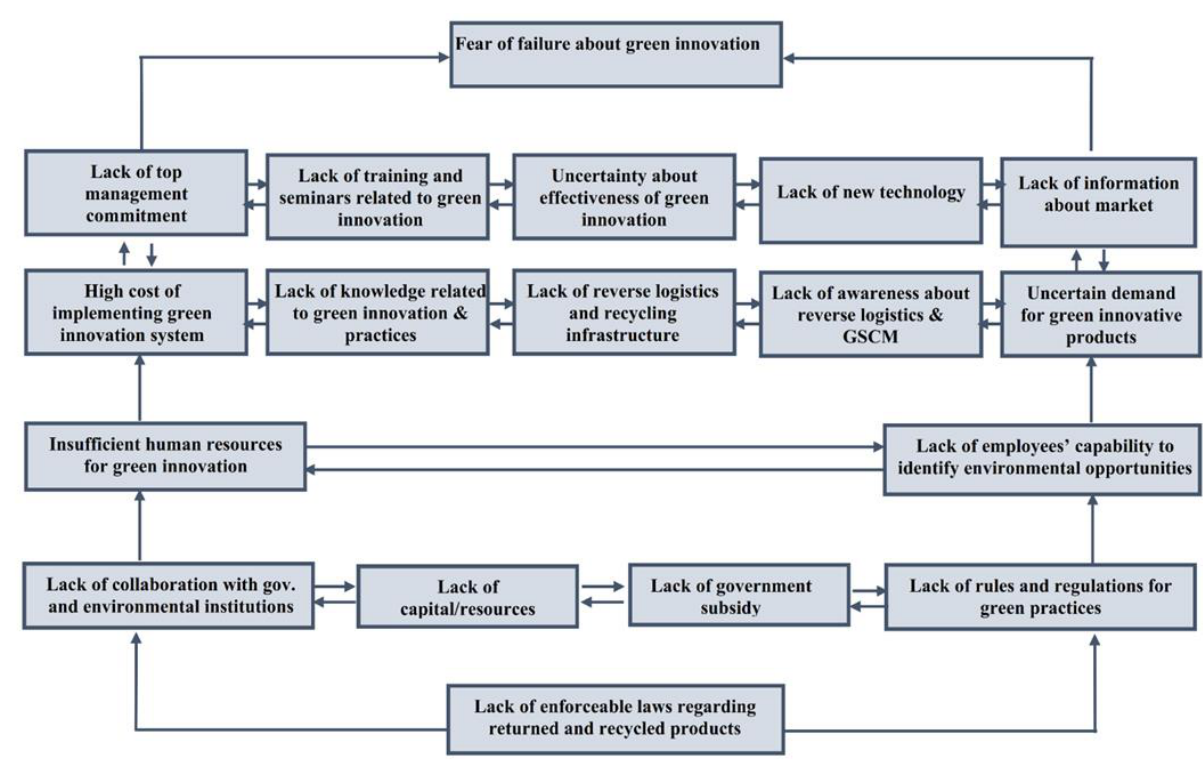
Figure 3. ISM based model and hierarchal level of barriers affecting green innovation implementation in the manufacturing industry of Pakistan.